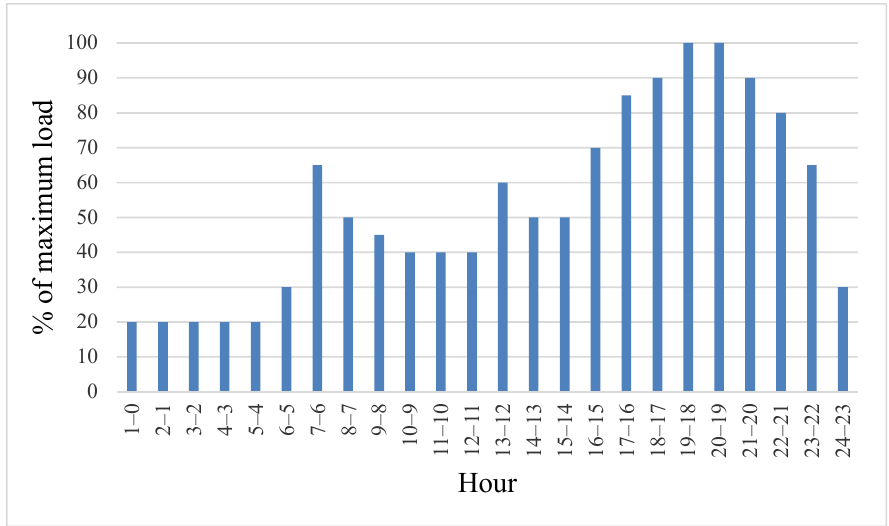
Figure 3. Load curve for household electricity consumption for a weekday in January 2019 (percentage of the sectoral maximum load). Source: own elaboration with the model [27].